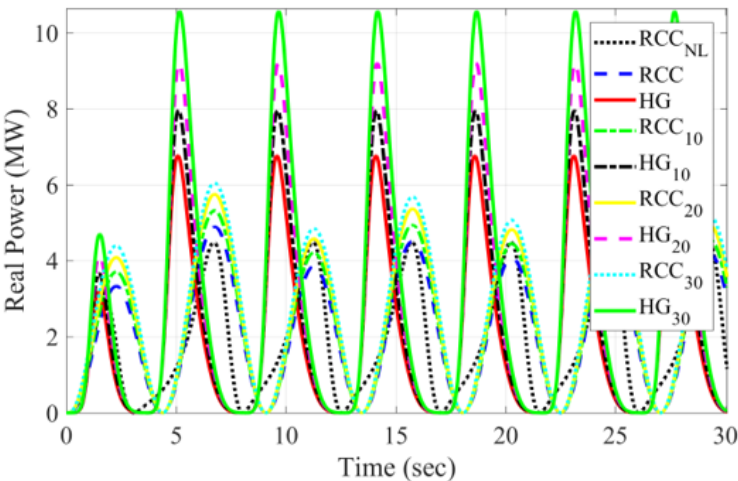
Figure 15. Real powers for the first 30 s of 100 s duration for all cases,